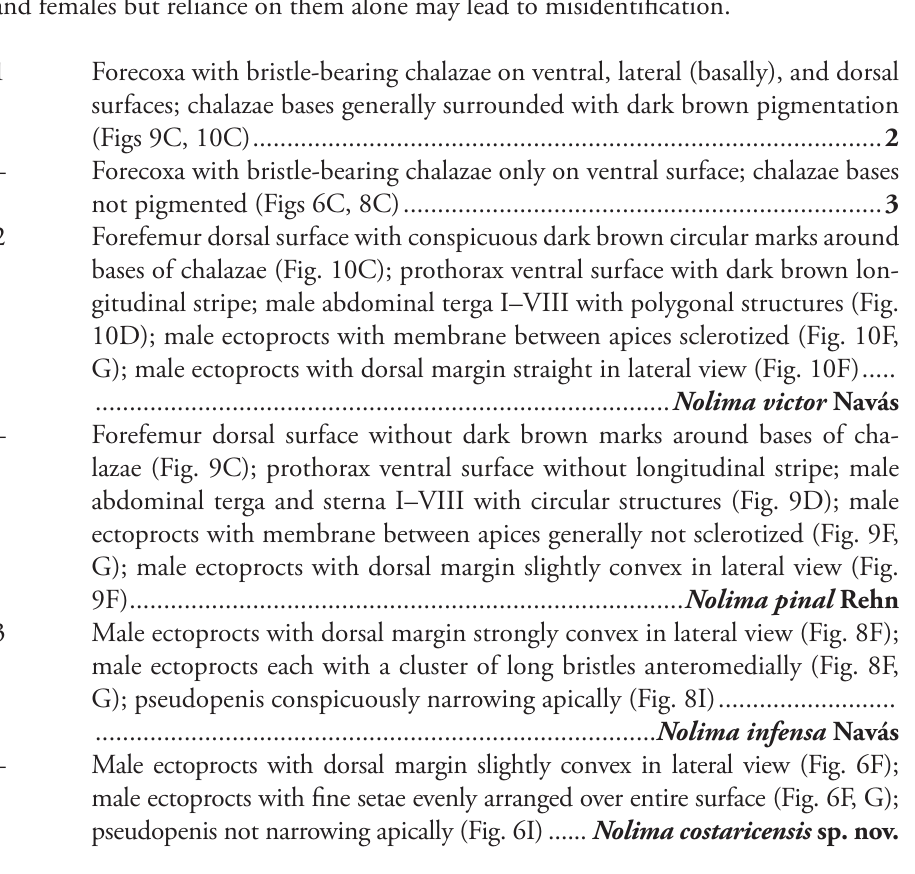
Forecoxa with bristle-bearing chalazae on ventral, lateral (basally), and dorsal surfaces; chalazae bases generally surrounded with dark brown pigmentation (Figs 9C, 10C) ............................................................................................ 2 Forecoxa with bristle-bearing chalazae only on ventral surface; chalazae bases not pigmented (Figs 6C, 8C) ...................................................................... 3 Forefemur dorsal surface with conspicuous dark brown circular marks around bases of chalazae (Fig. 10C); prothorax ventral surface with dark brown lon- gitudinal stripe; male abdominal terga I–VIII with polygonal structures (Fig. 10D); male ectoprocts with membrane between apices sclerotized (Fig. 10F, G); male ectoprocts with dorsal margin straight in lateral view (Fig. 10F) ..... – Forefemur dorsal surface without dark brown marks around bases of cha- lazae (Fig. 9C); prothorax ventral surface without longitudinal stripe; male abdominal terga and sterna I–VIII with circular structures (Fig. 9D); male ectoprocts with membrane between apices generally not sclerotized (Fig. 9F, G); male ectoprocts with dorsal margin slightly convex in lateral view (Fig. 3 Male ectoprocts with dorsal margin strongly convex in lateral view (Fig. 8F); male ectoprocts each with a cluster of long bristles anteromedially (Fig. 8F, G); pseudopenis conspicuously narrowing apically (Fig. 8I) .......................... – Male ectoprocts with dorsal margin slightly convex in lateral view (Fig. 6F); male ectoprocts with fine setae evenly arranged over entire surface (Fig. 6F, G); pseudopenis not narrowing apically (Fig. 6I) ...... Nolima costaricensis sp.